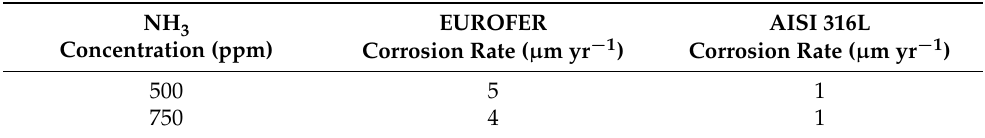
Table 2. Corrosion rates of EUROFER and AISI 316L in ammonia water